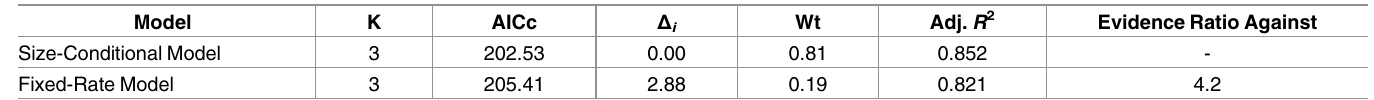
Table 4. Comparison of predictive models for adult abundance.